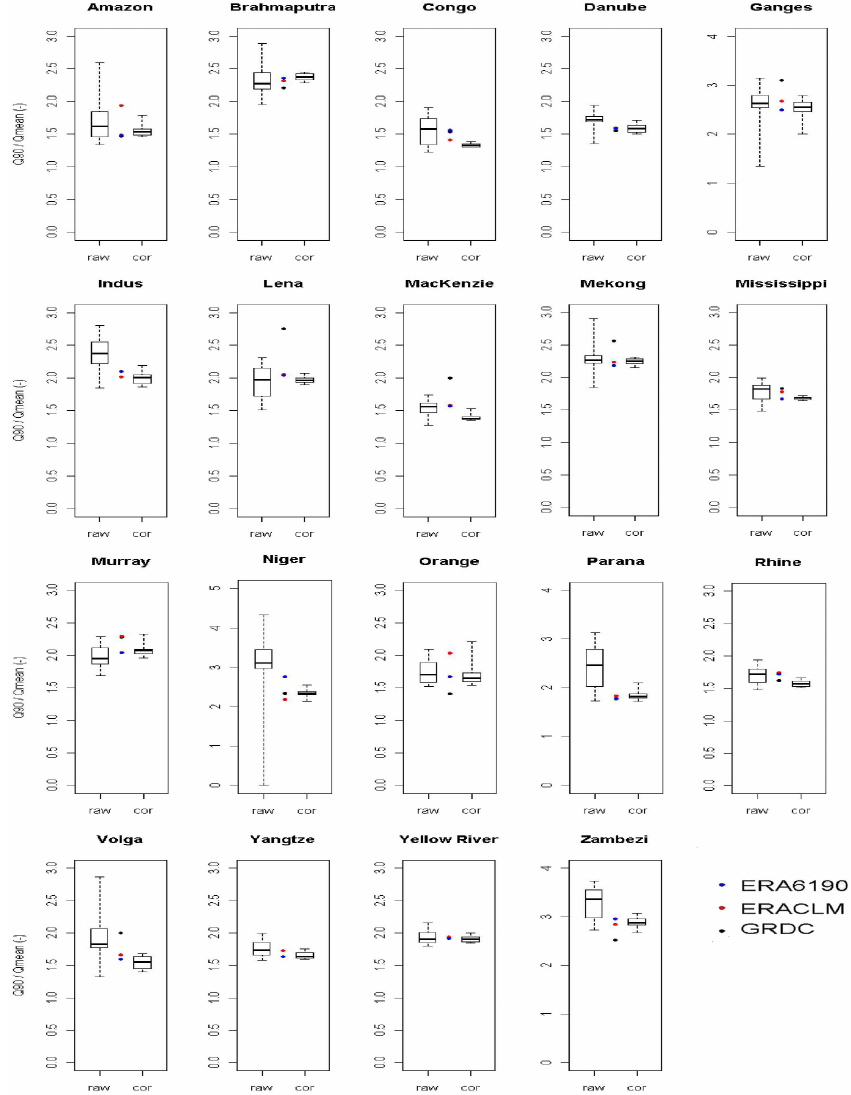
Figure 3: Thirty year average relative Q90 values ( Q 90 /Q (–)) for the ensemble of GCMs (boxes are drawn between the quartiles and whiskers represent minimum and maximum values), the ERA6190 run (blue points), the ERCLM run (red points) and the GRDC observations (black points).